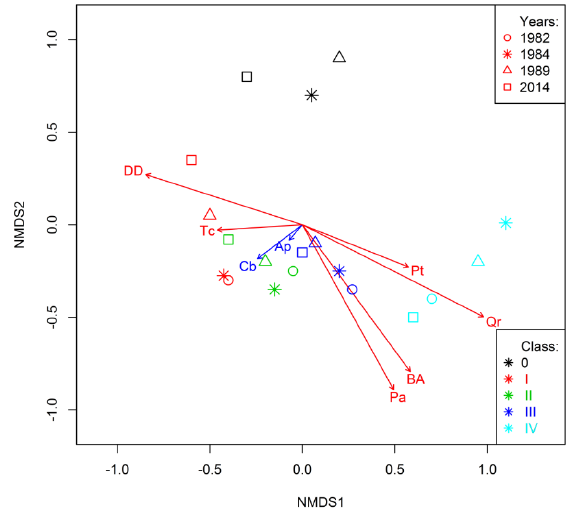
Figure 4. Ordination of study plots in subsequent survey years and tree classes vs environmental vectors based on nonmetric multidimensional scaling (NMDS). Bray-Curtis distance. Stress = 0.19. Designations of vectors are the same as in Figure 3. Vectors significantly correlated with the loca- tion of a study plot are marked in red. R2 for vectors: BA-0.26, Qr-0.33, Cb-0.03, Ap-< 0.01, Tc-0.06, Pt-0.10, Pa- 0.28, DD-0.22. The shape of the points corresponds to the years of measurement and the color to the class of trees.